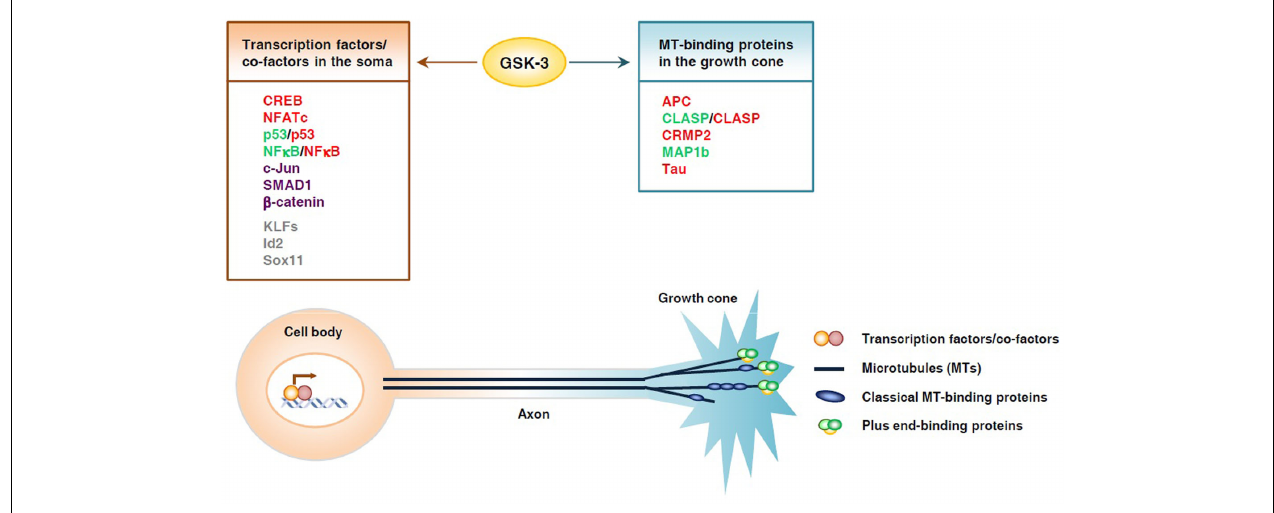
axon regeneration is determined by the coordination between gene expression and local cytoskeletal assembly at the growth cone. Substrates whose activities are inhibited by GSK3 are depicted in red, those that are activated by GSK3 are depicted in green. Some substrates, such as p53 and NF κ B, can be either activated or inhibited upon GSK3 phosphorylation, depending on the context. Substrates that undergo proteasomal degradation when phosphorylated by GSK3 are depicted in purple. Putative substrates are shown in